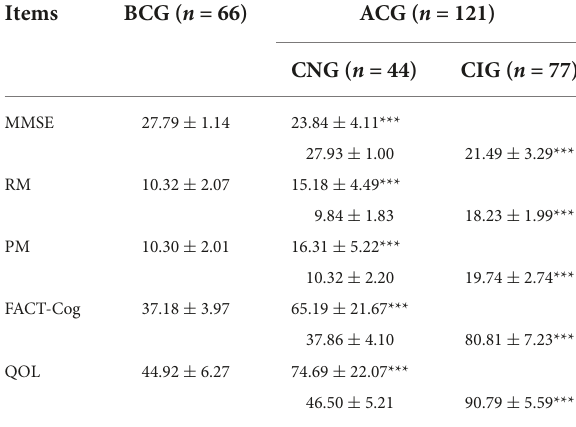
TABLE 3 Comparison of peripheral blood biomarkers (NLR, CEA, and CA153) levels in the BCG and ACG.